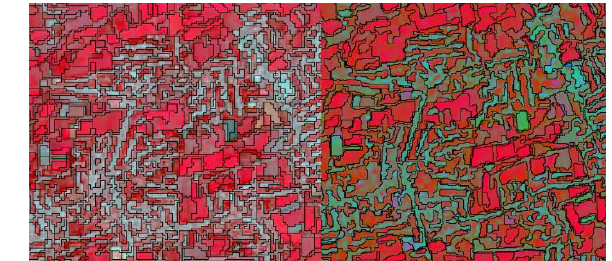
Figure 6. Image segmentation experiments with the original Landsat data (left) and the Ehlers Fusion image (right).